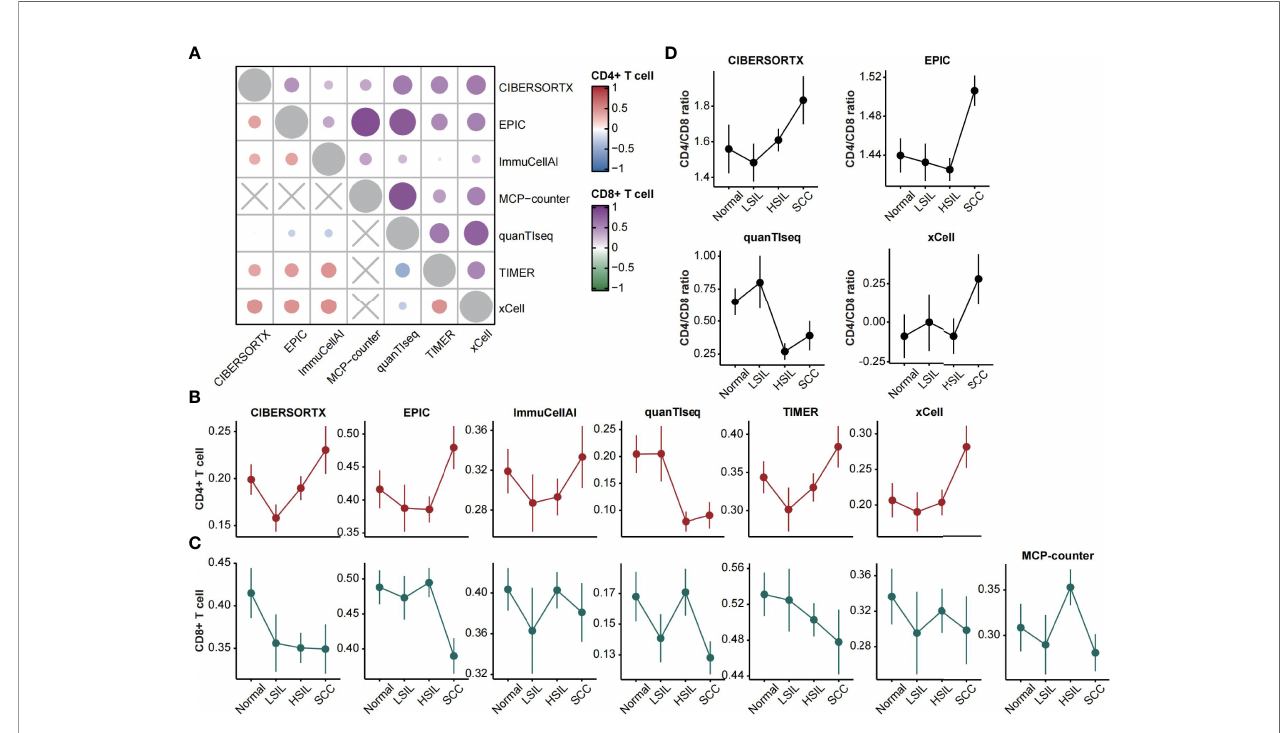
FIGURE 2 | CD4 + and CD8 + T cells estimation. (A) Heatmap displaying average Spearman correlations of seven computational methods for the CD4 + (left bottom) and CD8 + (right top) T cells abundance across disease stages. (B, C) Line plots showing the abundance of CD4 + and CD8 + T cells (mean ± SEM) changes over disease stages. The estimated scores were normalized between zero and one. (D) Line plots showing the CD4/CD8 ratio (mean ± SEM) changes over disease